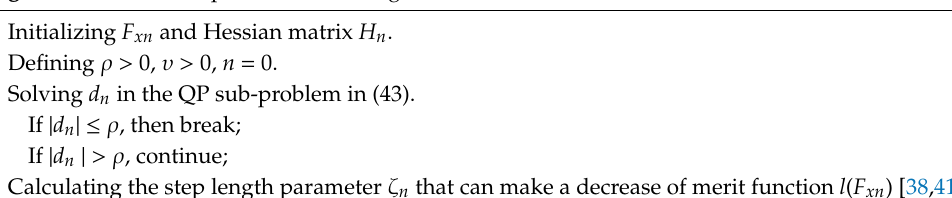
Algorithm 1: Iteration process of SQP